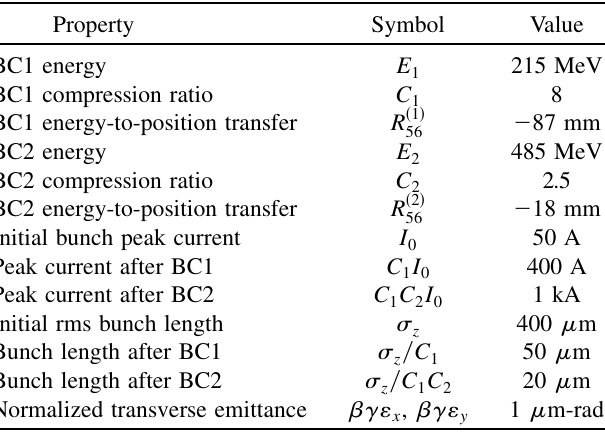
TABLE I. Parameters describing the chicanes BC1 and BC2 and the compression of 200-pC parabolic